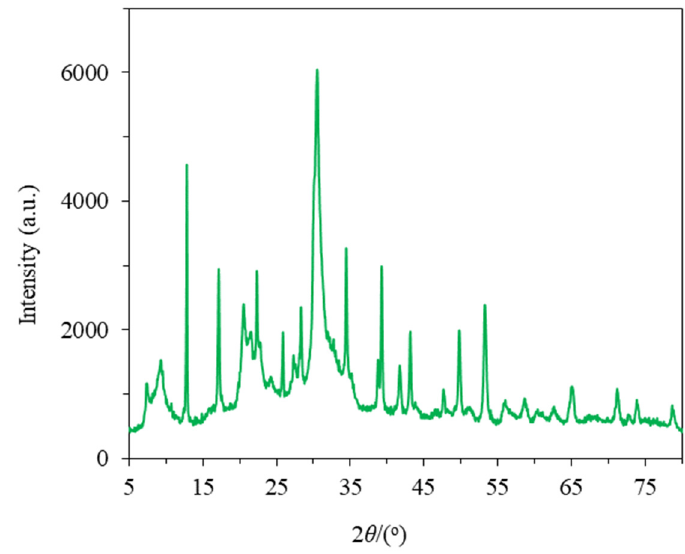
Figure 3. XRD pattern of KCHA zeolite membrane.